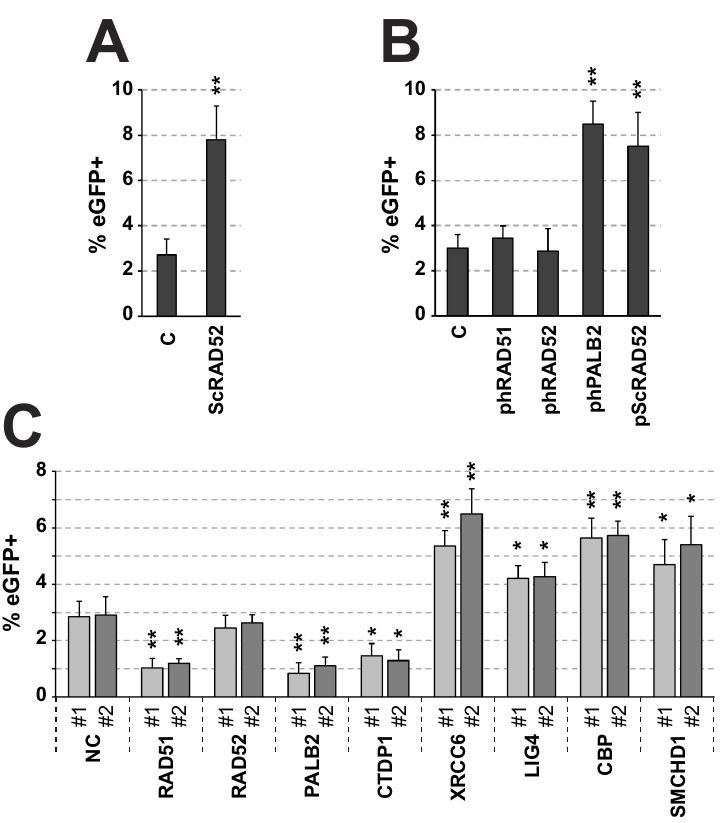
Fig 5. Validation of our eGFP-based assay for measuring the frequency of HR. (A) Effect of the addition of TAT-NLS-ScRAD52 on HR rates in our assay. Control cells (C) were treated with an equal volume of vehicle (see Materials and Methods). (B) Effect of the overexpression of plasmid-encoded HR promoters on HR rates. Empty pcDNA3 vector (vector) served as control. (C) Impact of various siRNAs targeting DNA repair-related genes on the frequency of HR. Two independent siRNAs were tested for each of the silenced genes. Two negative control siRNAs were used: NC#1 served as a negative control for all Silencer Select siRNAs and NC#2 served as a negative control for classical siRNAs (this information is available in S3 Table ). Results are depicted as percentage of eGFP+ cells. Mean values with SD are shown (n = 3 independent experiments). � p < 0.05, �� p < 0.01, ��� p < 0.001. Raw data underlying these results and representative flow cytometry dot plots graphs showing the number of eGFP+ cells are available in S2 Fig . plasmid at the same times as those of the overexpression experiments described above. We used two siRNAs for each of the following genes: RAD51, RAD52, PALB2, CTDP1, XRCC6, LIG4, CBP and SMCHD1. As indicated above, RAD51, RAD52, and PALB2 play a major role in HR-mediated DNA repair [28–30], as does CTDP1 [31]. The efficacy of the siRNAs in gene silencing was validated by real-time PCR assay (S3 Fig) . As expected, the silencing of RAD51, PALB2 and CTDP1 led to a significant decrease in the HR rate (Fig 5C) . The silencing of RAD52 had no effect, which we comment on in the discussion section. The XRCC6 and LIG4 genes encode protein Ku70 and human ATP-dependent DNA ligase respectively, which are the components of the NHEJ repair pathway [32]. It has been reported that a decrease in NHEJ leads to a compensatory increase in HR. Accordingly, XRCC6- and LIG4-silenced reporter cells exhibited increased frequency of HR ( Fig 5C ). Similarly, reporter cells silenced for CBP and SMCHD1 expression exhibited increased frequency of HR. It is important to note that both CBP and SMCHD1 facilitate the recruitment of NHEJ factors at DSB sites, so their depletion was also expected to lead to an increase in HR rates [33, 34]. Of note, the silencing of